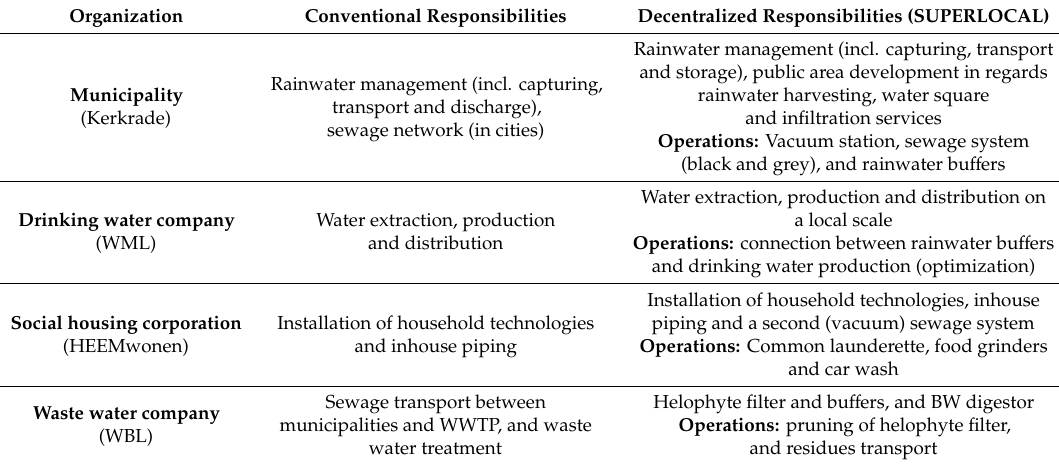
Table 1. Main actors and responsibilities involved in the case